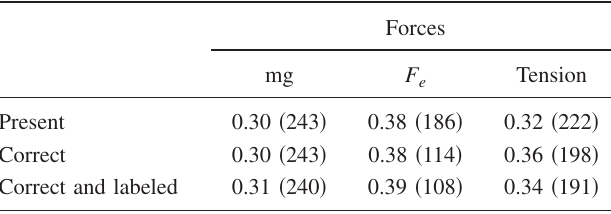
TABLE IV. Fraction of students answering the challenge prob- lem correctly, shown for each force available in the problem and broken down according to whether that force was present, drawn correctly, or drawn correctly and labeled. Data for CU and Rutgers are very similar, so we display only those for CU.